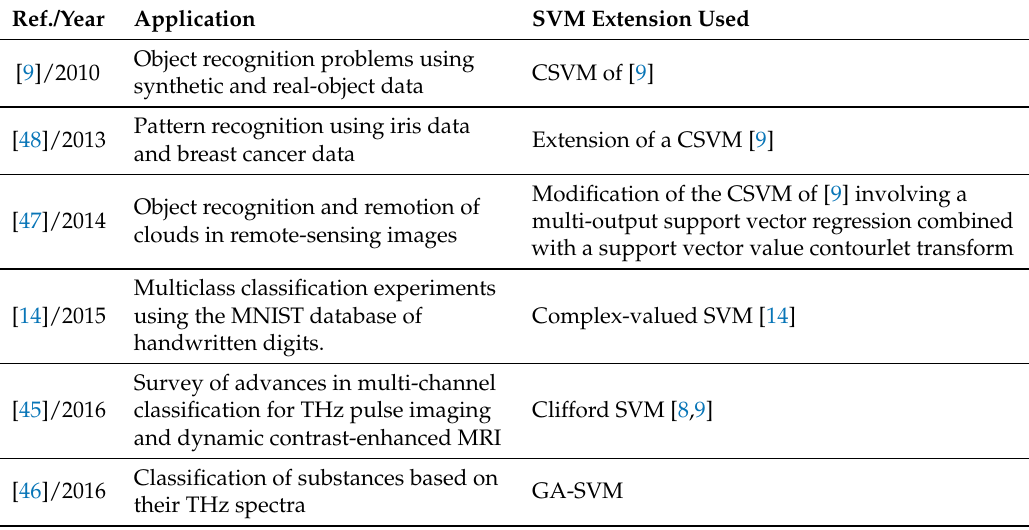
Table 3. Applications of complex and hypercomplex SVMs for solving pattern recognition